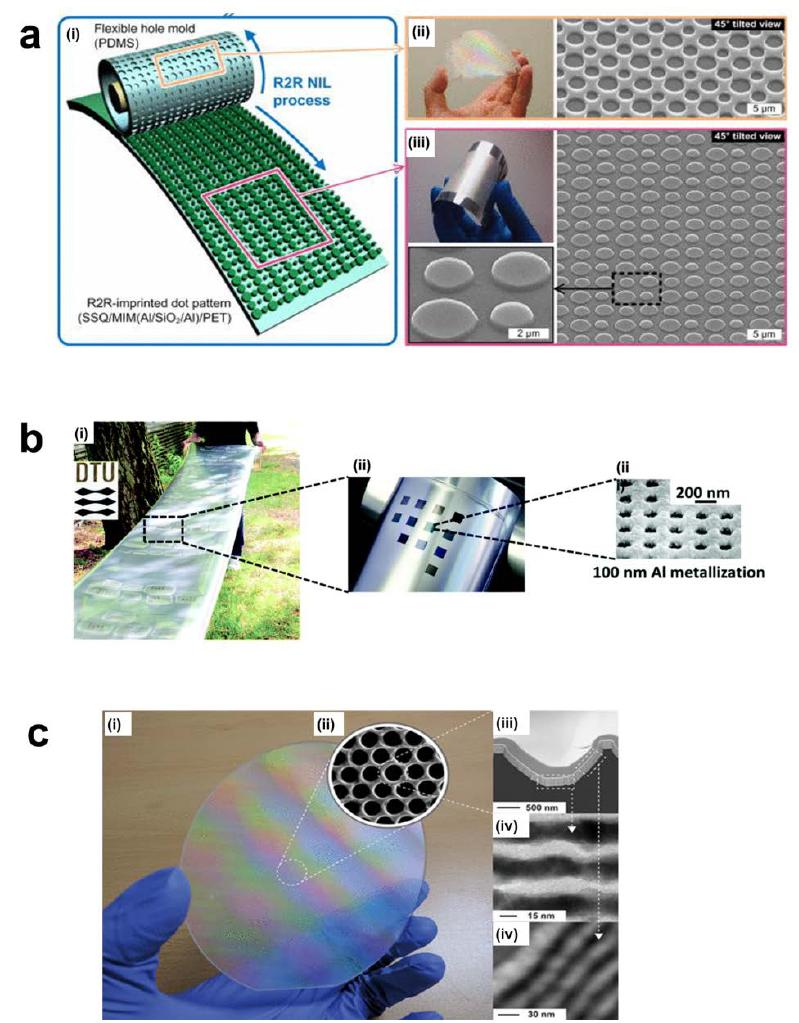
Figure 9. ( a ) (i) Illustration of the overall fabrication of R2R imprint based on the flexible p olydimethylsiloxane (PDMS) mold, (ii) rolling over a substrate under conformal contact, (iii) imprinting sot pattern with a very thin residual [171]. ( b ) A large-area plasmonic coloring metasurface using high-speed R2R method, (i) a polymer foil structure with 100 nm Al including the university logo fabricated by plasmonic color printing (1 × 1.5 cm), (ii) the magnified image of a plasmonic color patch, (iii) the SEM image of the patch with 100 nm metallization [173]. ( c ) (i) Photograph of a fabricated hyperlens product on a 4 inch wafer size. The SEM images of (ii) top view, (iii– v) The transmission electron microscopy (TEM) images of the single hyperlens with various magnification at